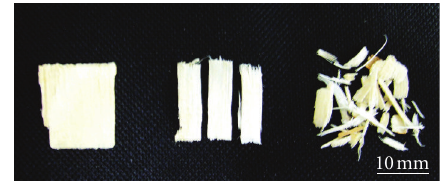
Figure 3: Examples of large, medium, and small wood